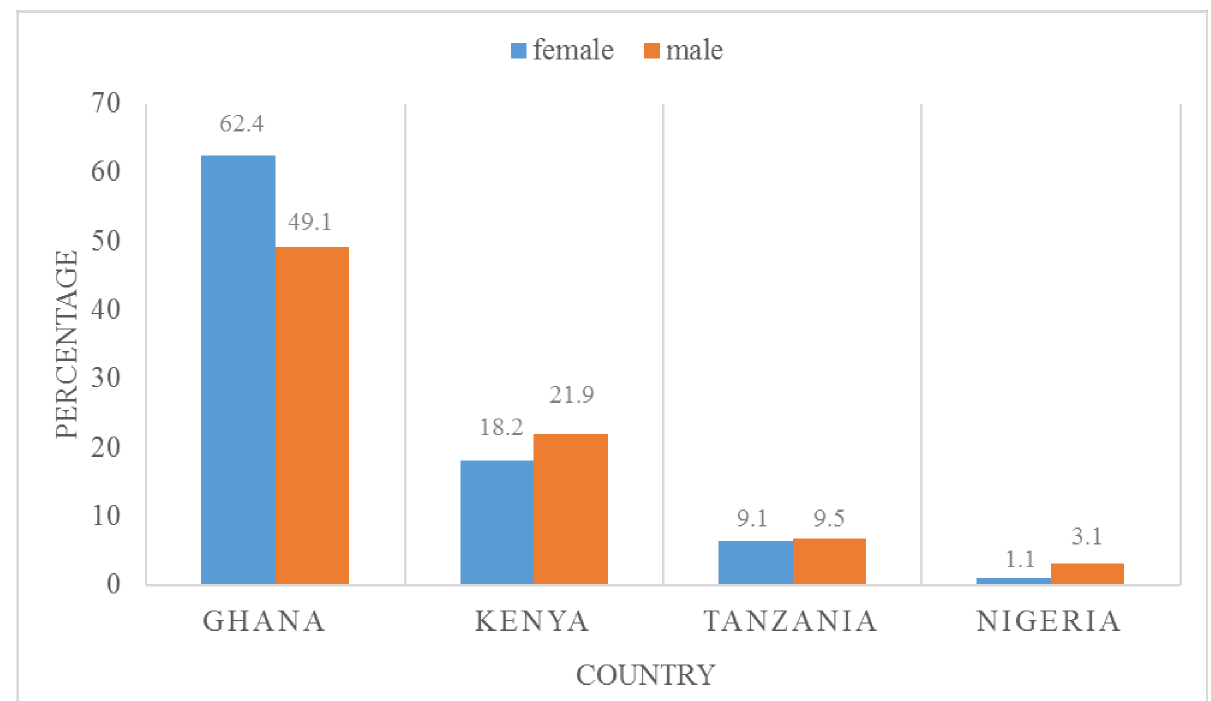
Fig 1. Health insurance coverage in Ghana, Kenya, Tanzania and